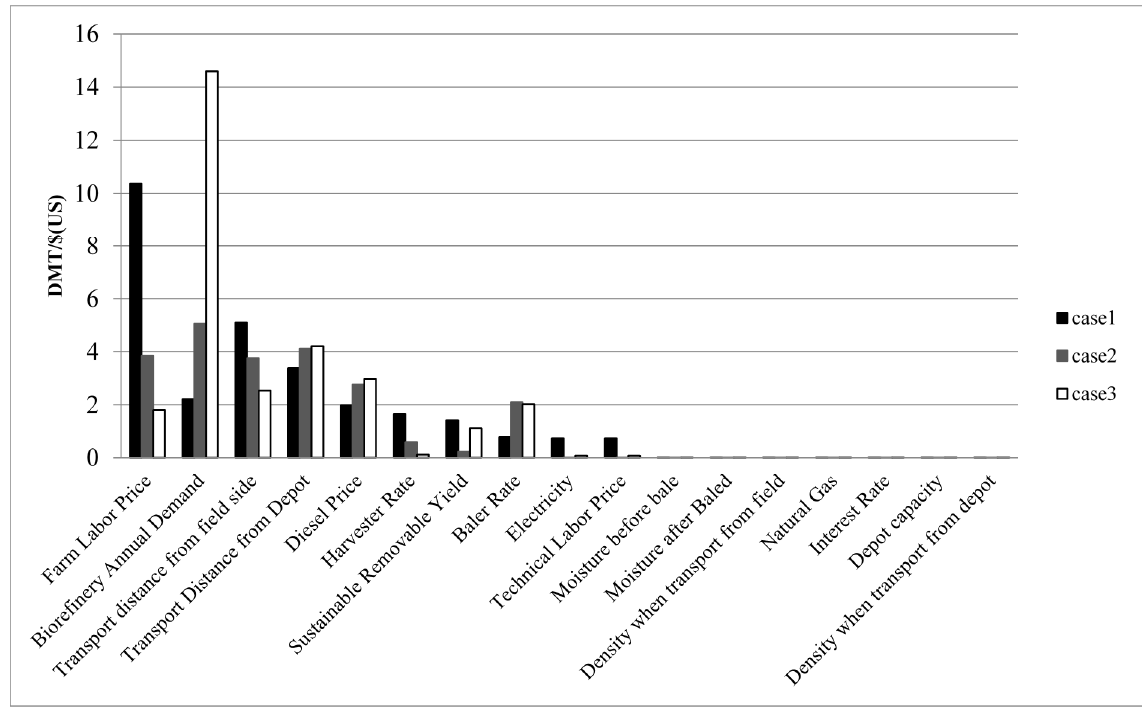
Figure 7. Pareto chart of BLM-Sino FS parameters by associated Contribution to total cost for sweet sorghum stalks in northeastern